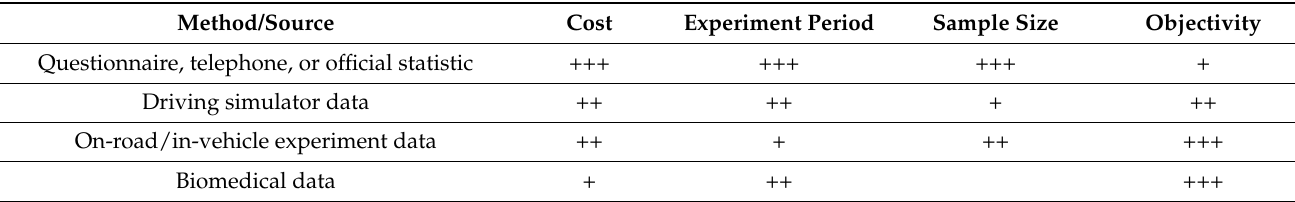
Table 7. Factors influencing methods to study older drivers’ behavior and stress. Method/Source Cost Experiment Period Sample Size